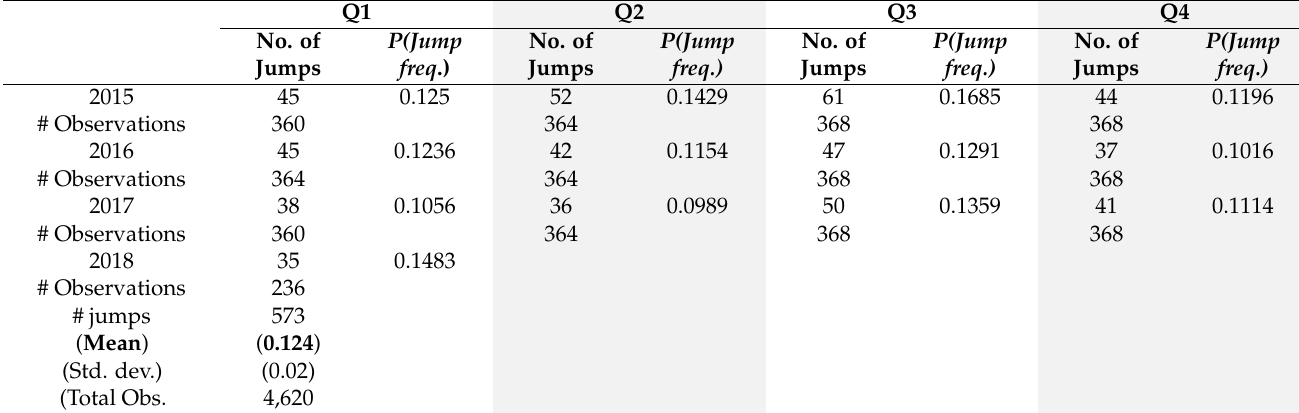
Table 1. Descriptive statistics on significant jumps using LM